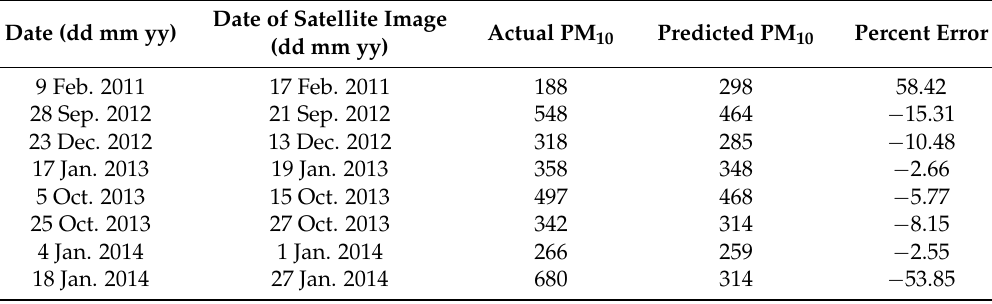
Table 3. Validation of daily maximum PM 10 with bare land